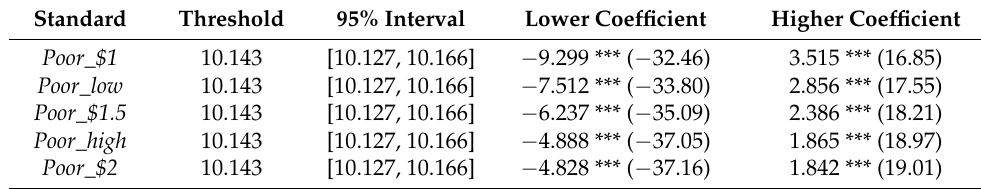
Table 22. Threshold estimates, confidence intervals, and coefficient changes.